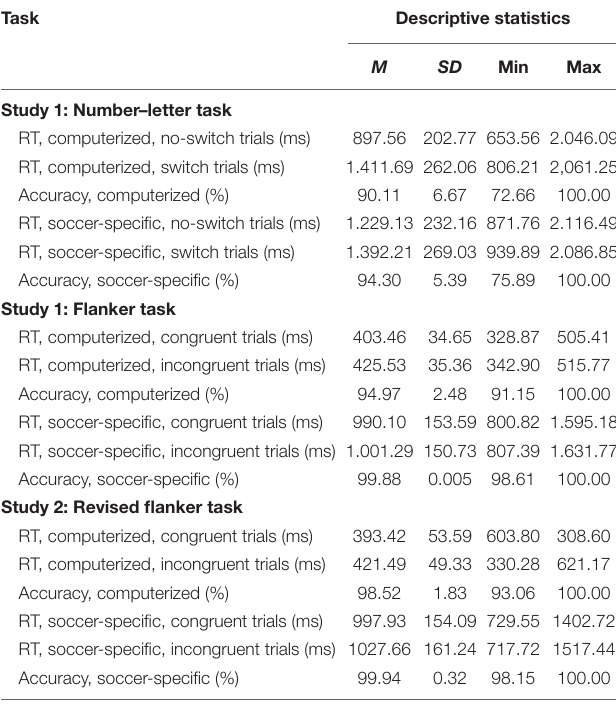
TABLE 1 | Descriptive statistics for the general, computerized and the soccer-specific versions of the tasks measuring inhibition (flanker; n = 72) and cognitive flexibility (number–letter; n =